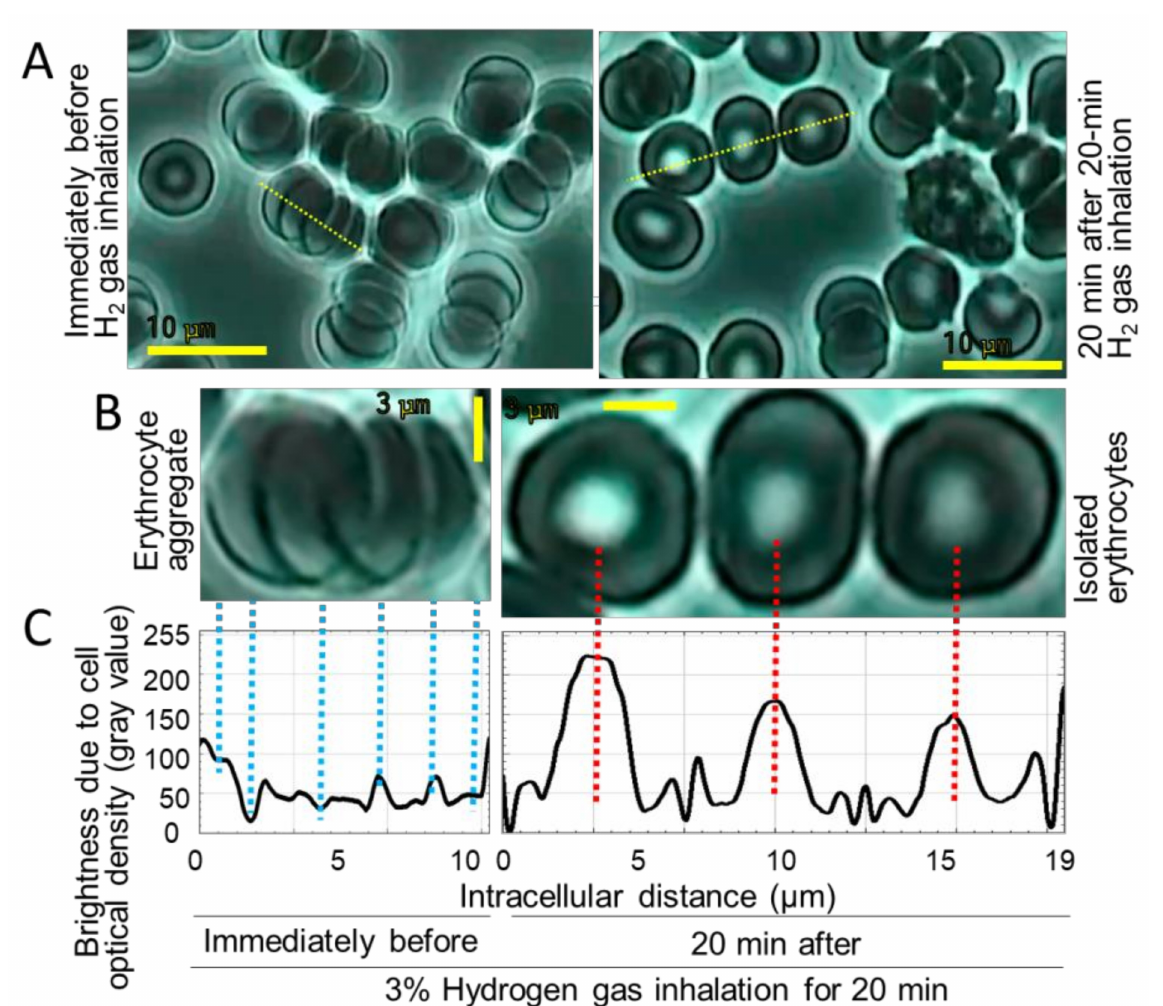
Figure 3. Suppressive effects of hydrogen gas inhalation on erythrocyte rosary-chain-like aggregation, together with retention of biconcave-discoid-shaped morphology in the erythrocyte center-part, called “central pallor”. ( A ) The micro-photograms immediately before inhalation and at 20 minutes after 20-min 3%-hydrogen-gas inhalation for a 46-year female subject. Bar: 10 µ m. ( B ) Enlarged micro- photograms of yellow dotted line portions of ( A ). Bar: 3 µ m. ( C ) Line histograms of intracellular optimetrical distribution for ( B